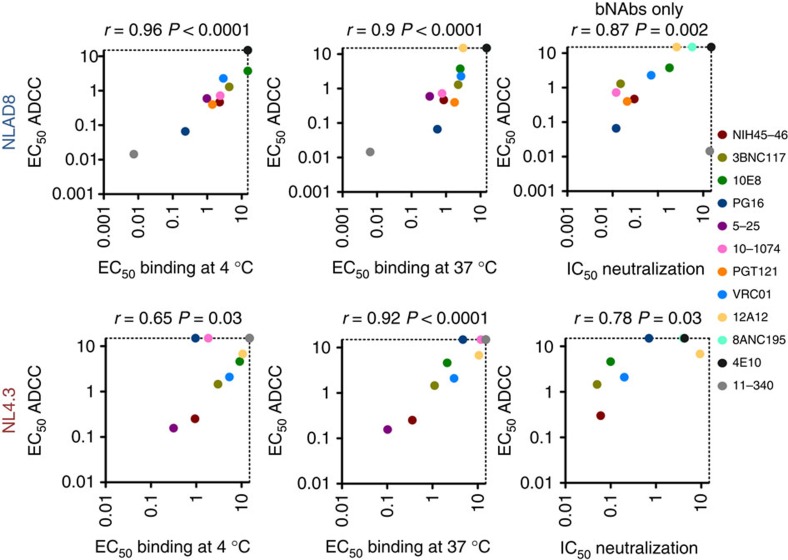
Correlates of ADCC activity of bNAbs.For each antibody, the efficacy of binding and of ADCC against CEM-NKR cells infected with NLAD8 or with NL43 was calculated. The neutralizing activity of the antibodies against cell-free HIV was tested in the TZM-bl assay. EC50 (in μg ml−1), defined as the effective concentration mediating 50% of the maximal effect, are summarized in Supplementary Table 2. Correlations were analysed by Spearman correlation coefficient (r).